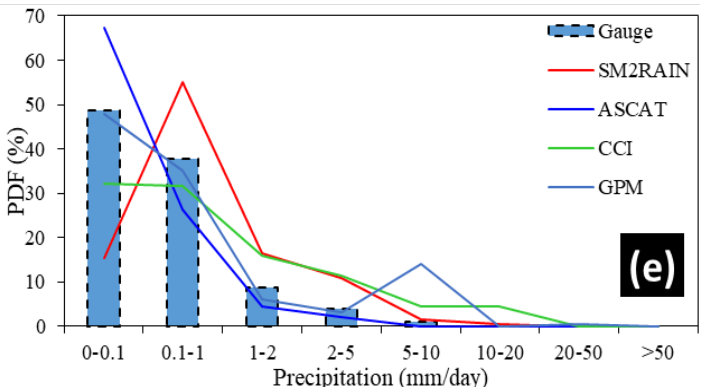
Figure 14. PDF (%) of all SPPs on daily and seasonal scales. ( a ) daily, ( b ) winter season, ( c ) spring season, ( d ) summer season, and ( e ) autumn season observation over Pakistan.